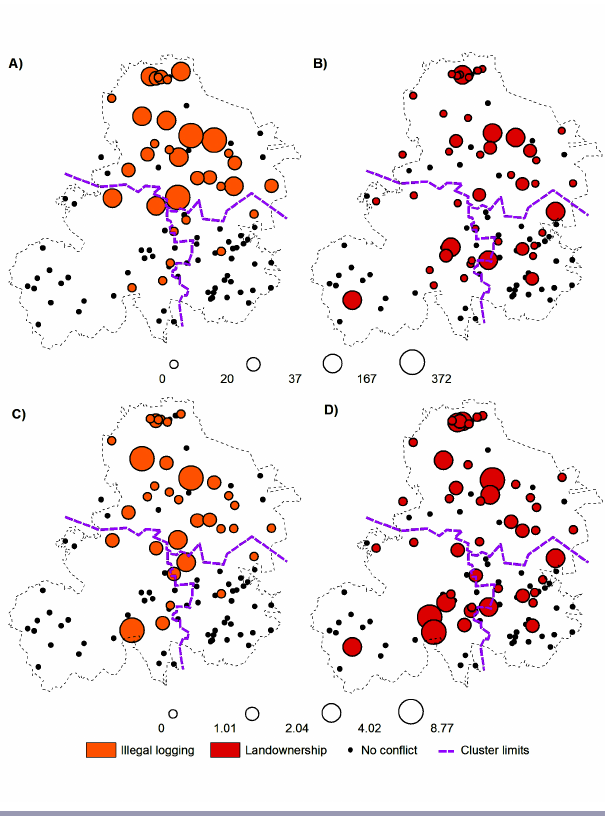
Fig. 5 . Intensity of conflicts per community regarding their kind of actors and expressions (A and B) and frequency per 1000 habitants (C and